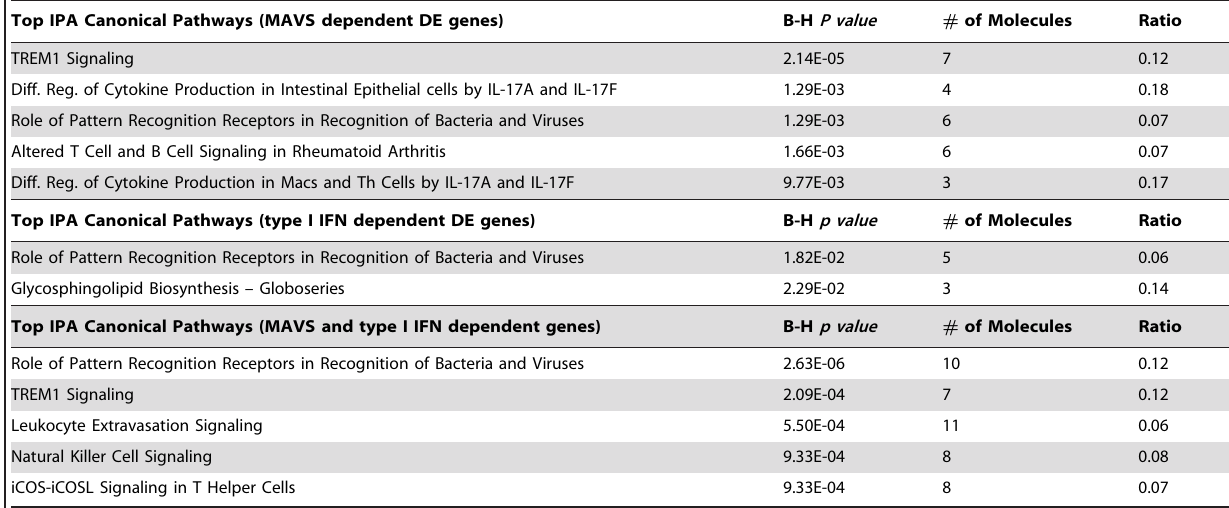
Top IPA Canonical Pathways (MAVS dependent DE